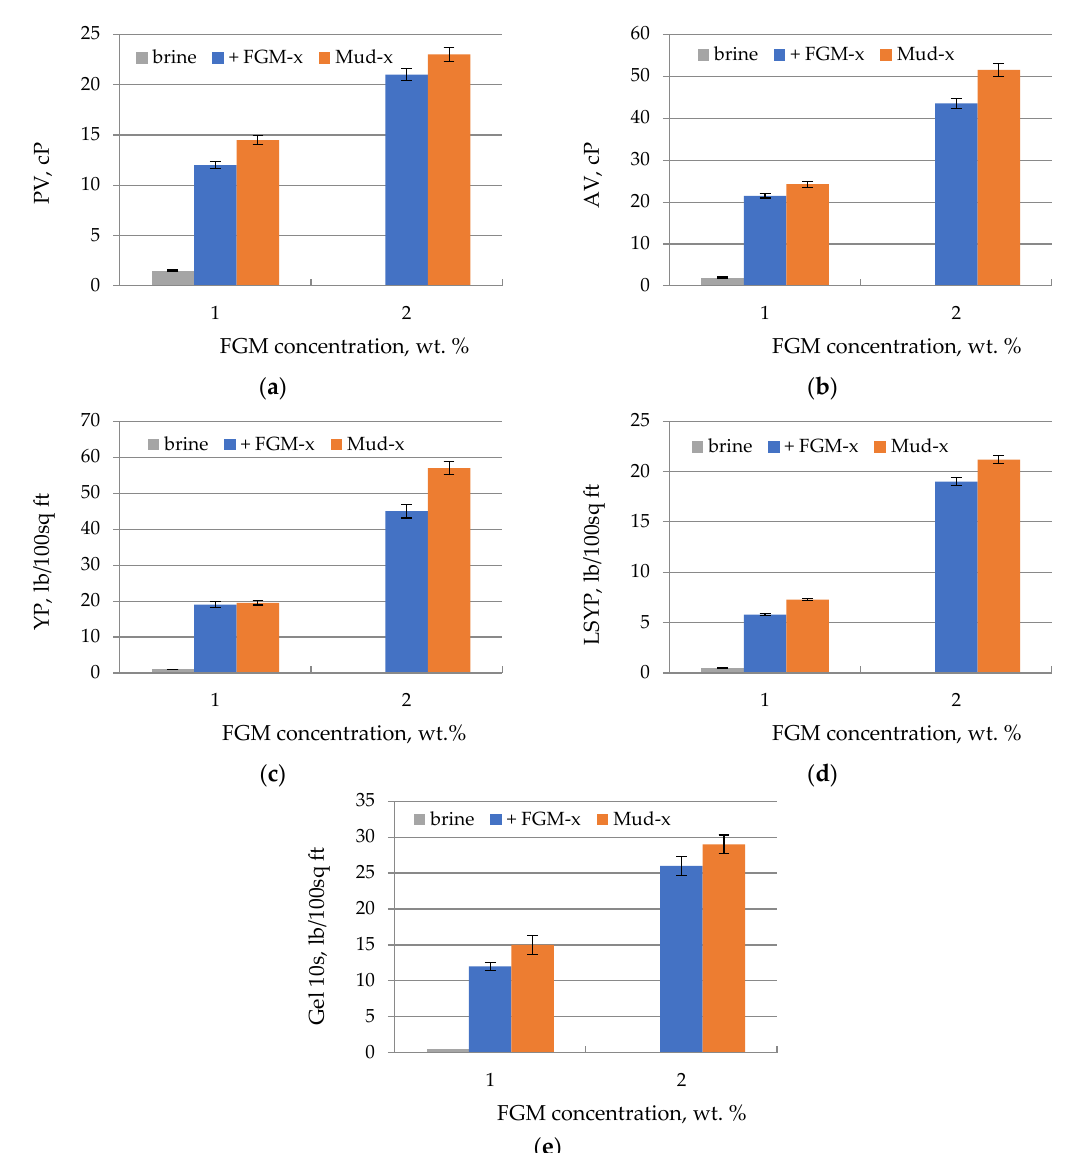
Figure 7. Comparison of rheological parameters of tested fluids ( a ) plastic viscosity (PV), ( b ) apparent viscosity (AV), ( c ) field point (YP), ( d ) low shear rate field point (LSYP), ( e ) 10-s gel strength (1 cP = 1 mPa × s, 1 lb/100sq ft = 0.4788 Pa).